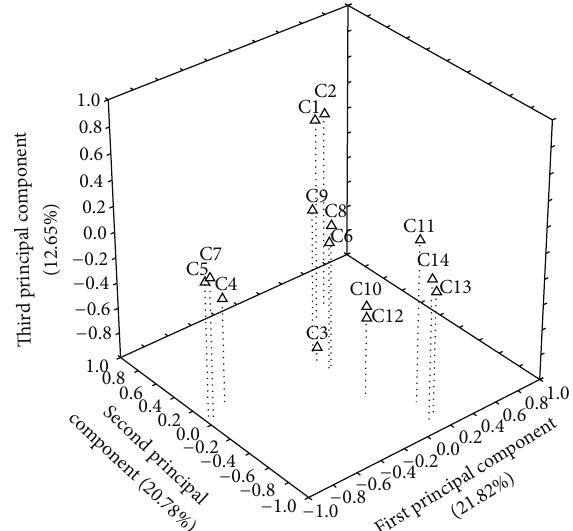
Figure 3: Distribution of the chemical constituents of the essential oil of Ocimum basilicum in relation to the three principal compo- nents through analysis of the principal component analysis (PCA) (C1 = 1,8-cineole, C2 = linalool, C3 = methyl chavicol, C4 = nerol, C5 = neral, C6 = geraniol, C7 = geranial, C8 = methyl cinnamate, C9 = 𝛽 -bourbonene, C10=methyl eugenol, C11= 𝛼 - trans -bergamotene, C12 = germacrene-D, C13 = 𝛿 -cadinene, and C14 = epi - 𝛼